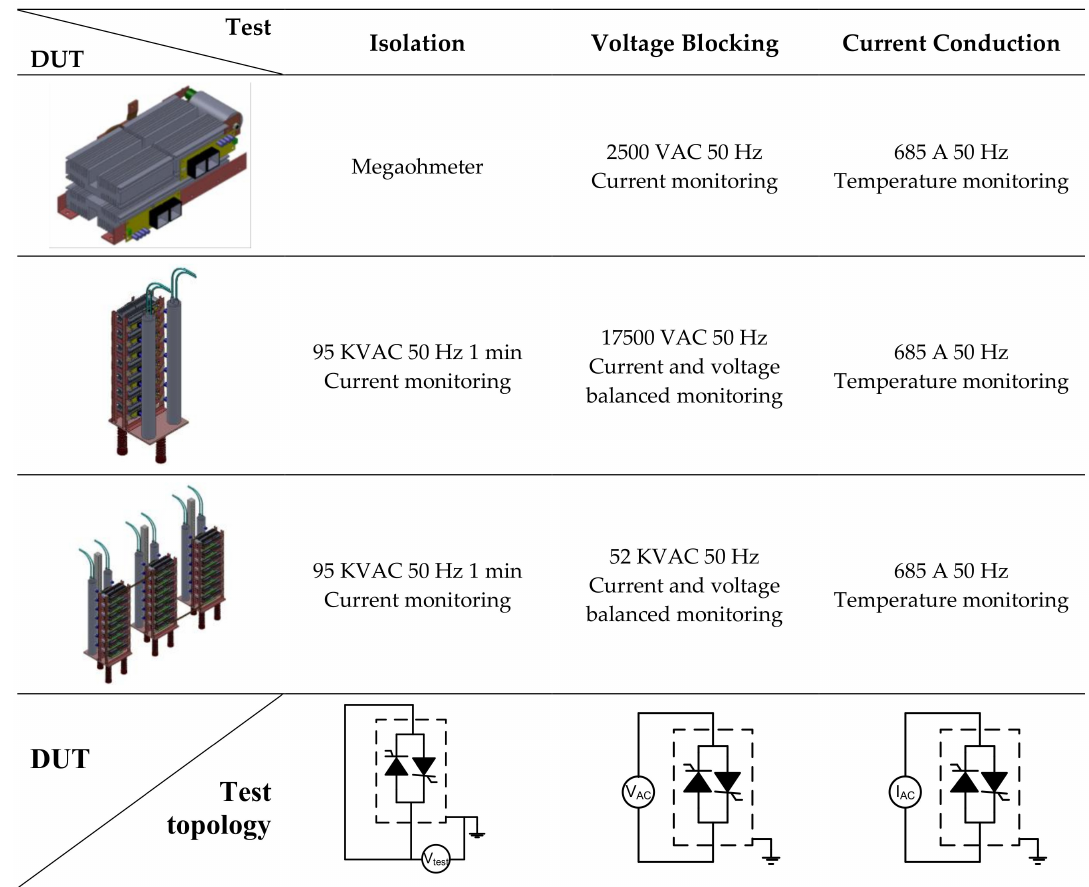
Figure 6. Procedure for the functional testing of the AC static switch. DUT, device under